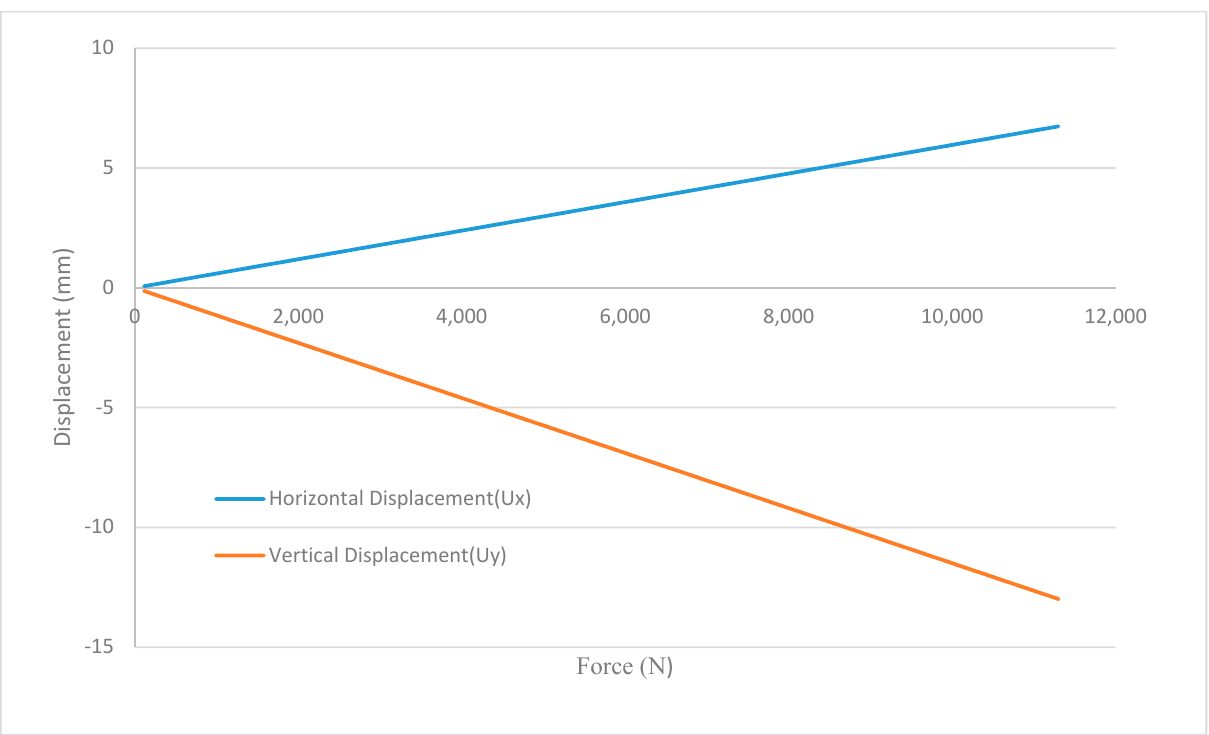
Figure 19. Horizontal and vertical displacements at node 20, element 1126 with coordinate details: ( x = 0, y = 0.25, z = − 4) and 10% FA.